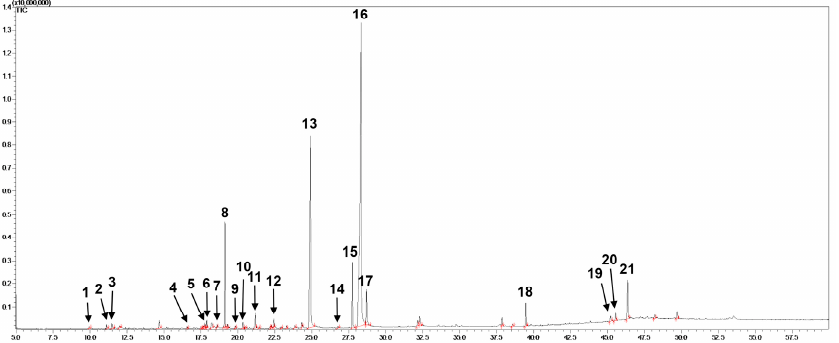
Figure 3. Identification of the constituents in EPF using GC-MS analysis. The total gas chromatogram of EPF is shown. Twenty-one compounds were identified in EPF. EPF, ethanol extract of Perilla frutescens leaves; GC-MS, gas chromatography–mass